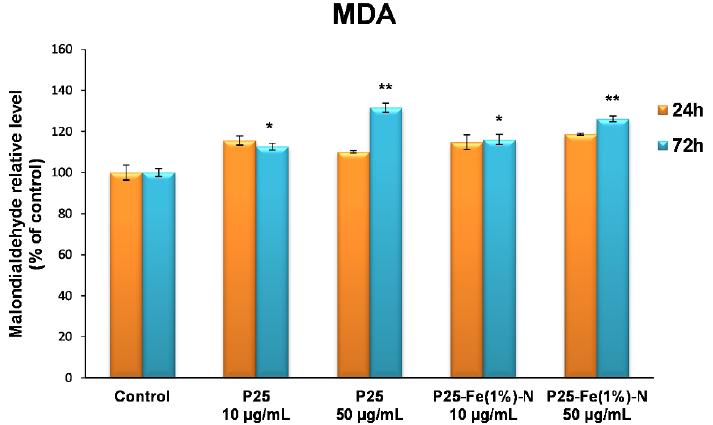
Figure 6. Malondialdehyde (MDA) levels in normal lung fibroblasts exposed to different concentra- tions (10 and 50 μg/mL) of the two TiO 2 NPs samples: P25 Degussa and P25-Fe(1%)-N for 24 h and 72 h. Results are expressed as means ± standard deviation (SD) ( n = 3) and represented relative to the untreated cells (control). * p < 0.05 and ** p < 0.01 compared to control.